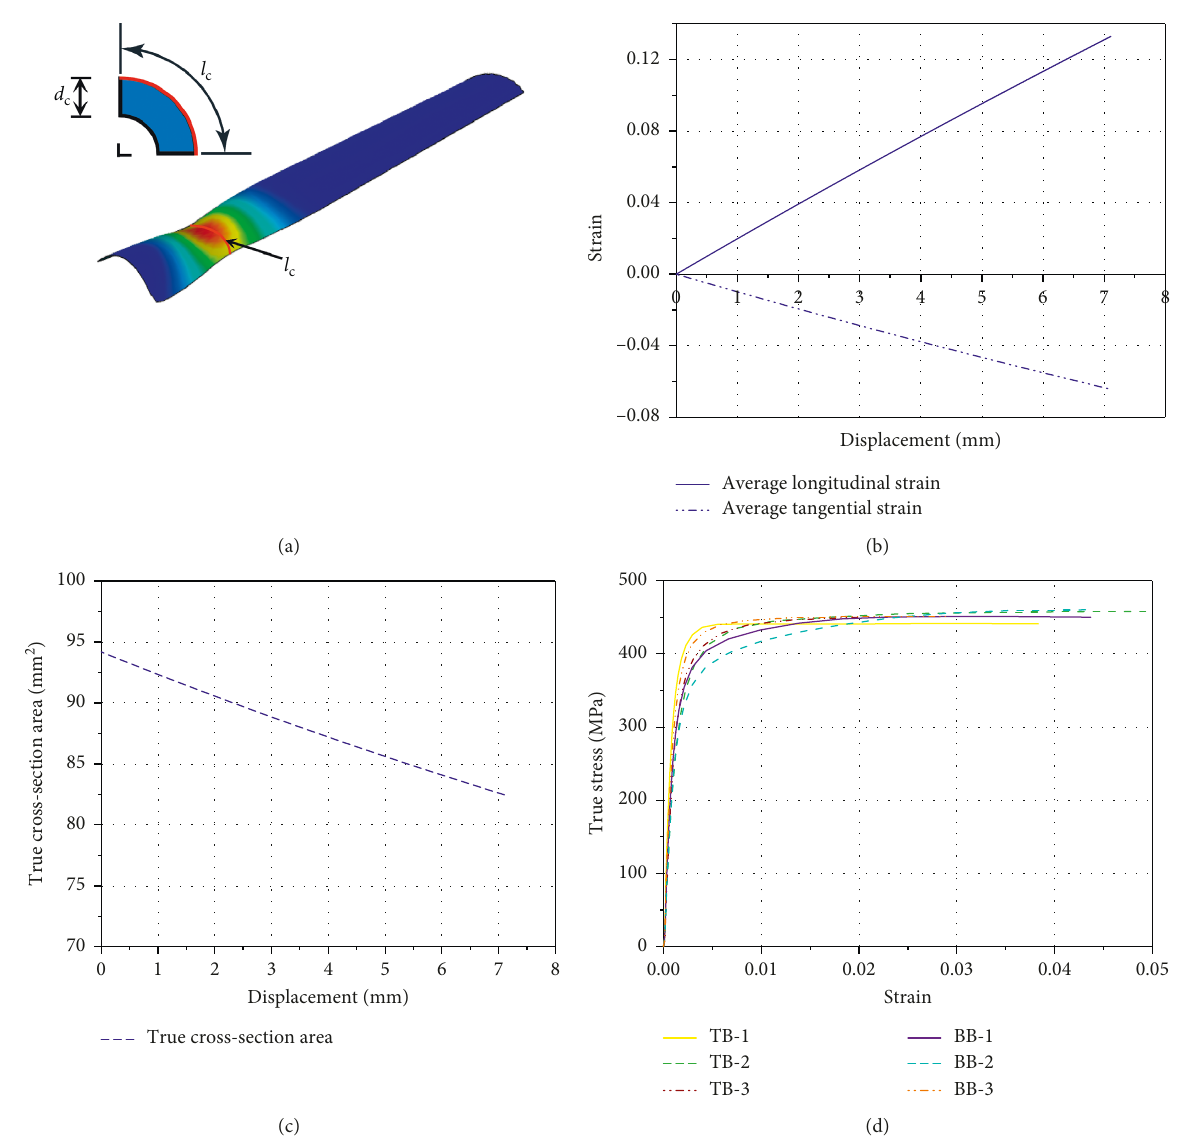
Figure 11: Capture of true stress-strain curves of corner coupon: (a) diagram of real-time section area capture of corner coupon; (b) average strain; (c) true cross-section area; (d) true stress-strain curves of corner